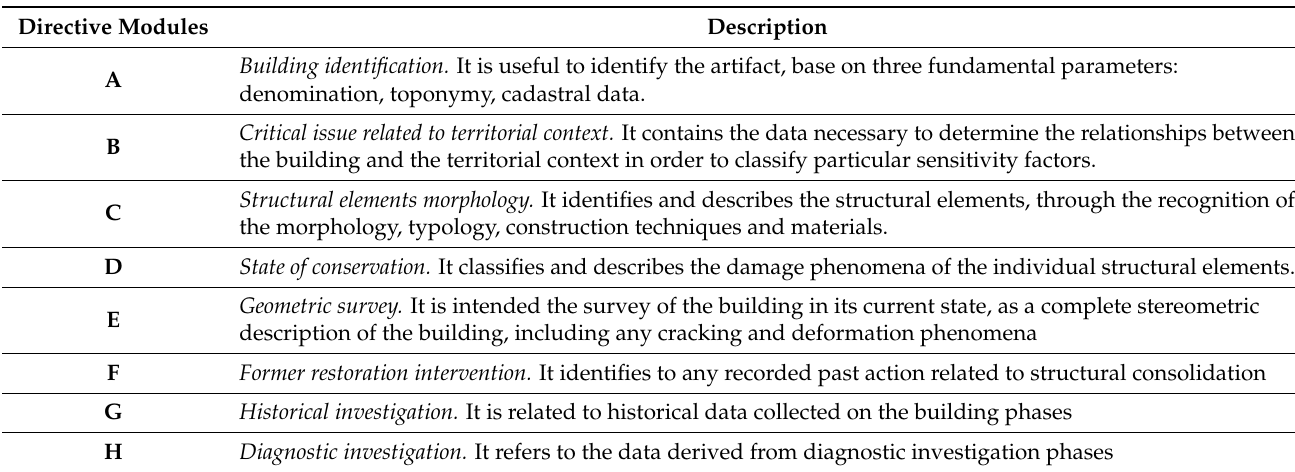
Table 1. Directive Modules from Italian regulation (DPCM 09/02/2011).